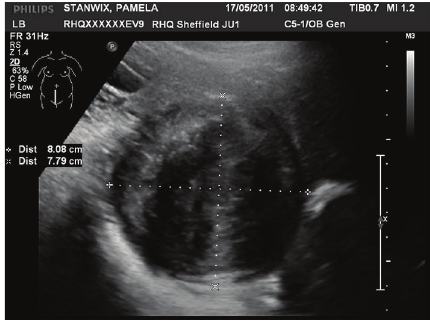
Figure 1: Cervical fibroid size at 20 weeks 8.08 × 7.79 cm.